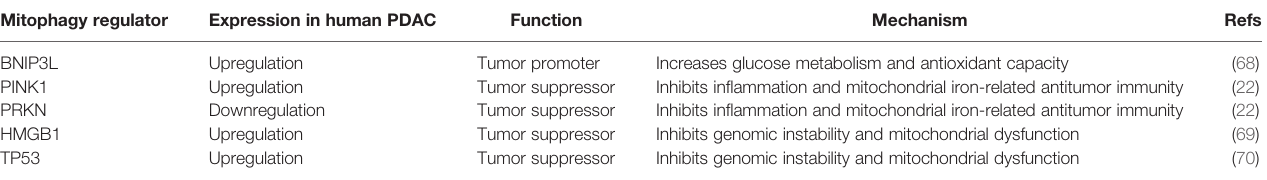
TABLE 1 | Mitophagy regulators in